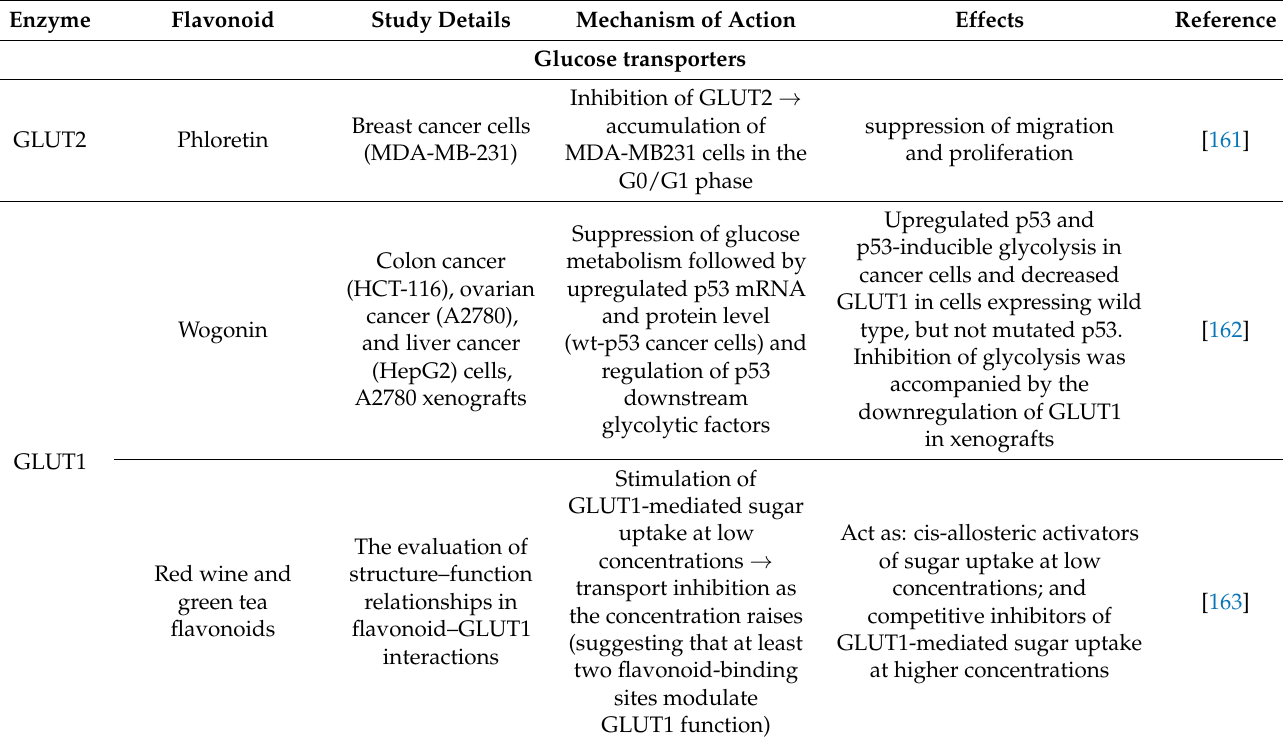
Table 4. Effects of flavonoids on glucose transporters and enzymes of glucose metabolism.